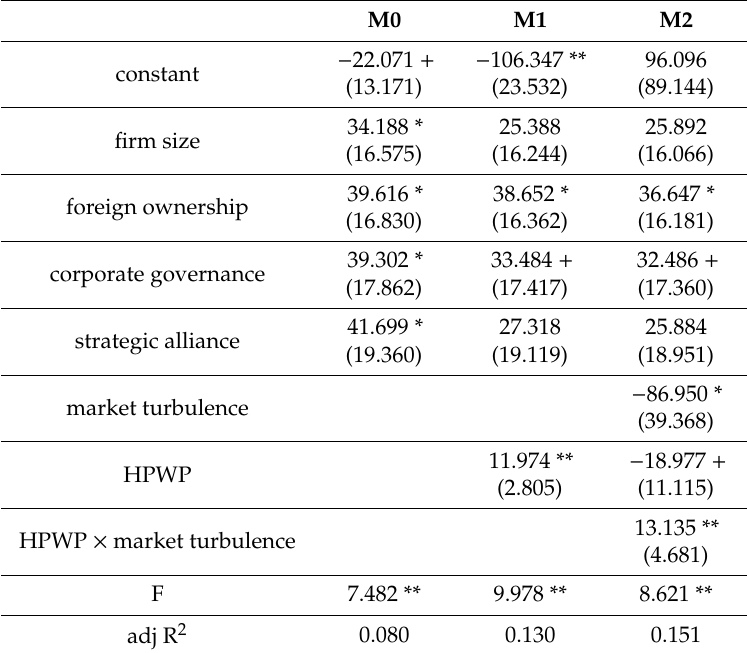
Table 3. Regression results for H1 and